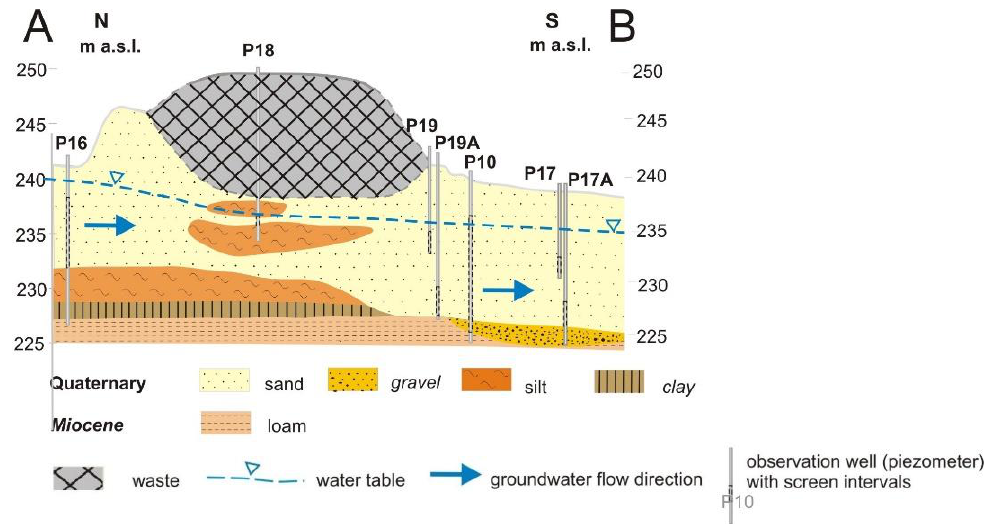
Figure 2. Geological cross-section of the study area (based on [10]).